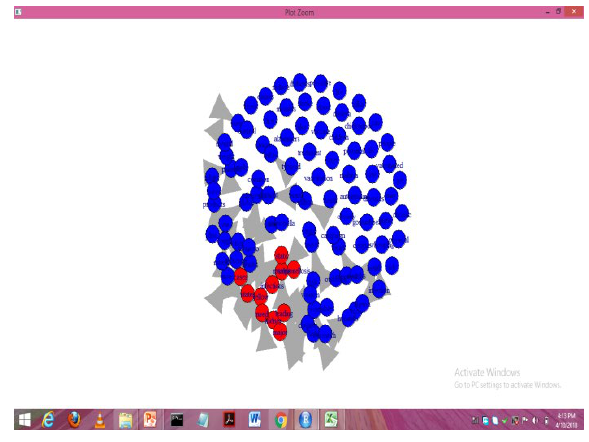
Fig. 1. Word cloud using the Min-cut algorithm